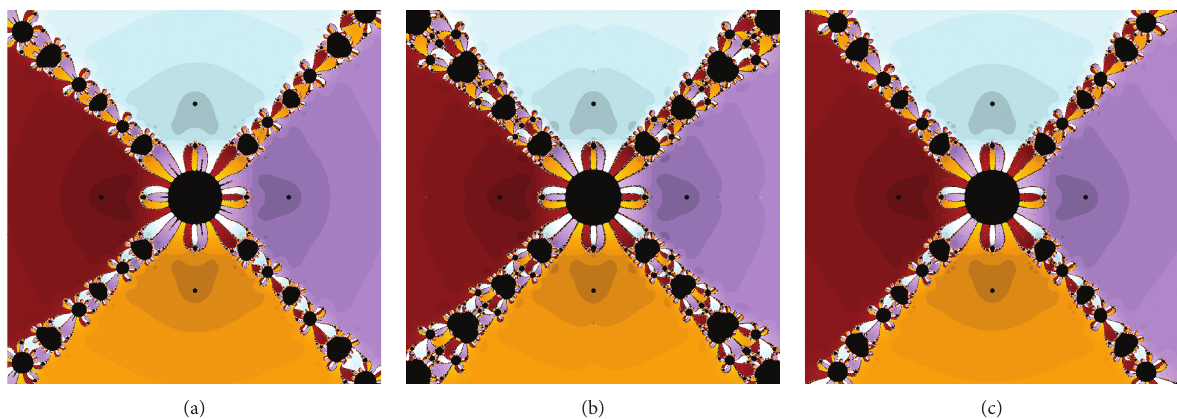
Figure 4: Basins of attraction associated with the polynomial p Algorithm 3.